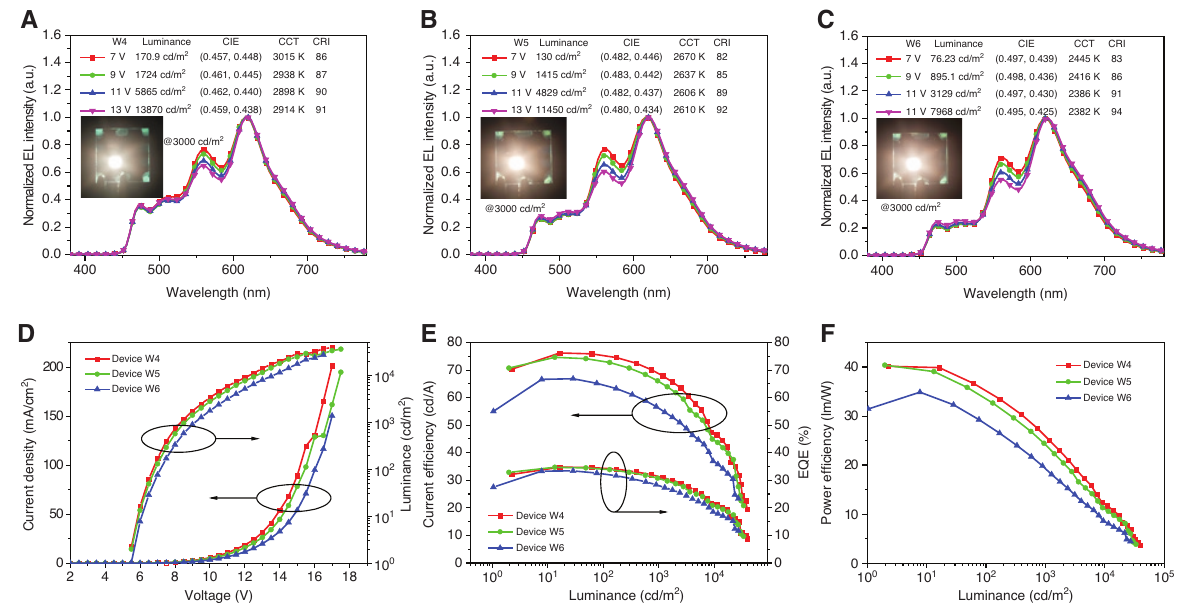
Figure 8: (A–C) The EL spectra of tandem four-color white devices W4–W6, and luminance, CIE coordinates, CCT, and CRI of these device at different voltages are also listed, and the inset in (A–C) are the photos of corresponding devices W4–W6 at a luminance of 3000 cd/m 2 ; (D–F) The J-V-L (D), CE-L-EQE (E), and PE-L (F) curves of tandem four-color white devices